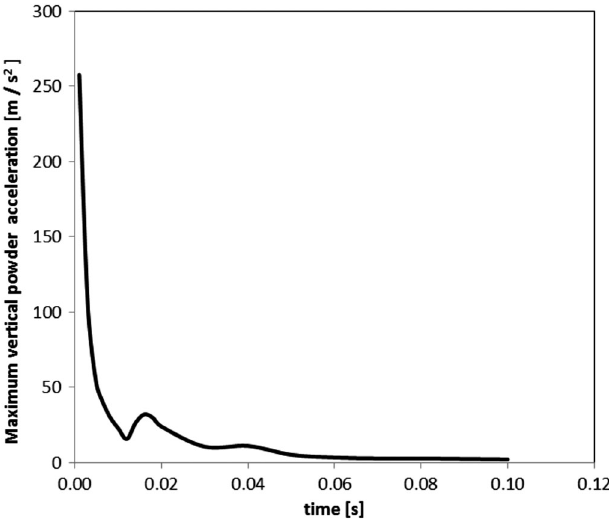
FIG. 19. Maximum vertical powder acceleration in the computa- tional domain following beam pulse; 2 . 2 × 10 11 protons on target.